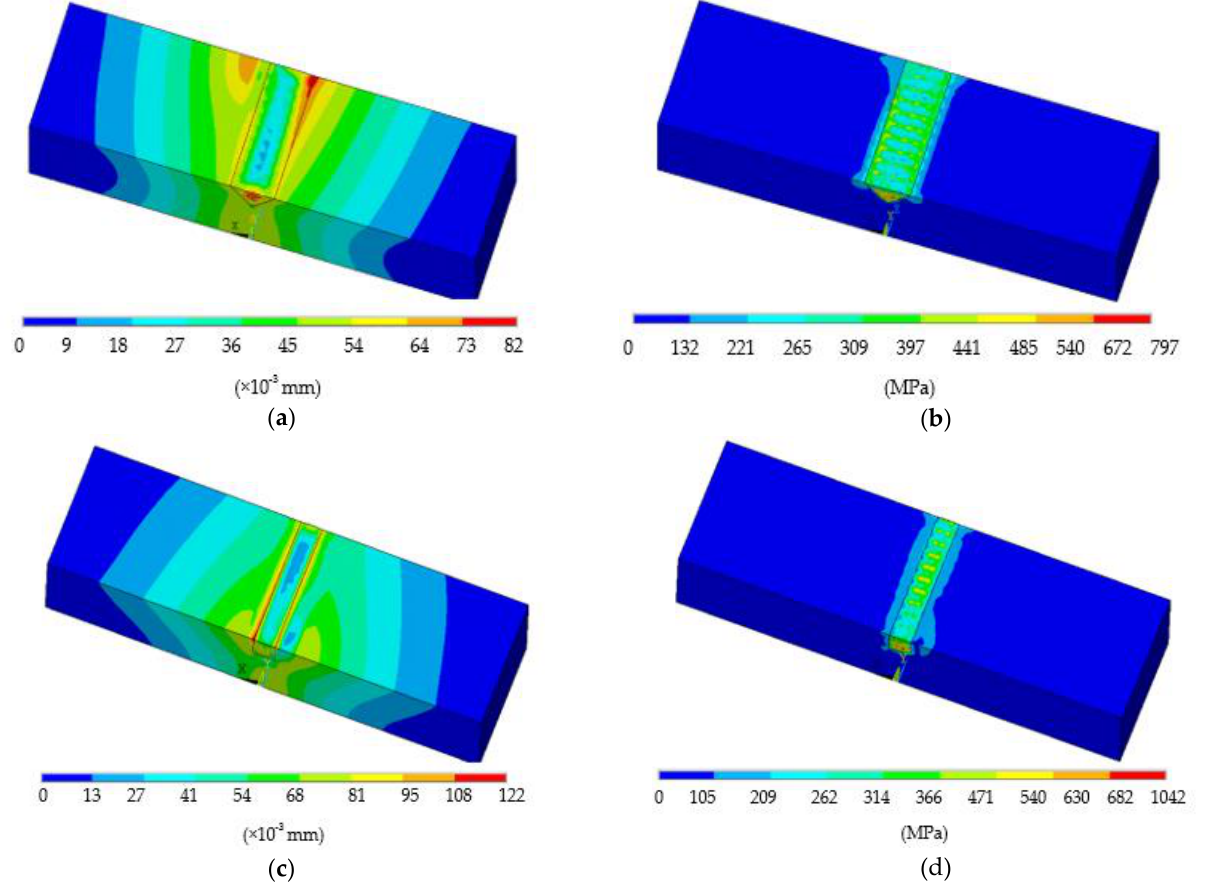
Figure 12. ( a ) Displacement vector sum, Usum; ( b ) Von Mises stress, Seqv, after deposition and cooling to room temperature in triangular ( c ) and rectangular ( d ) cases.